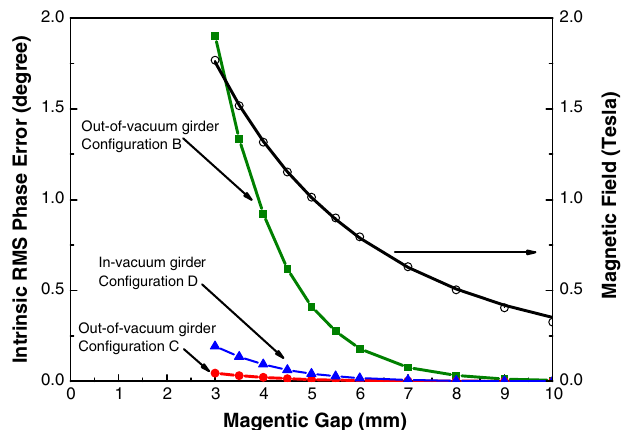
FIG. 8. Dependence of the intrinsic rms phase error and magnetic field as a function of the magnetic gap in the TPS CPMU for various